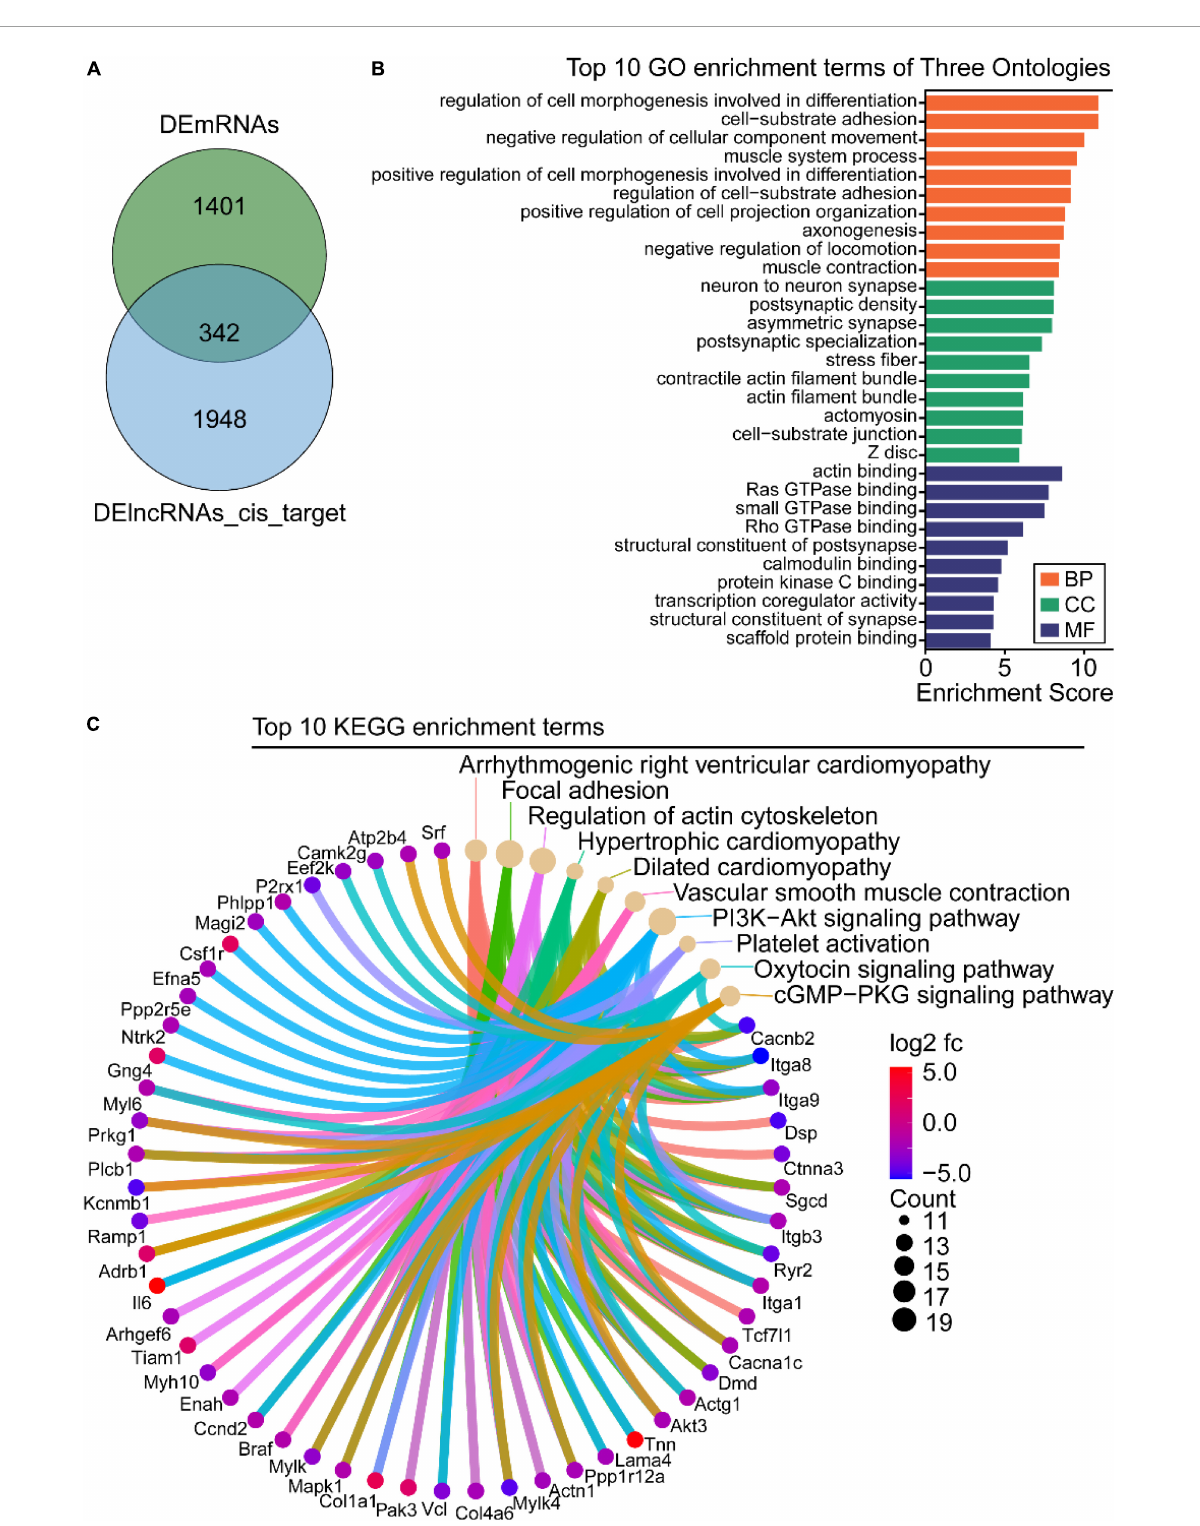
FIGURE7 Gene ontology (GO) and Kyoto Encyclopedia of Genes and Genome (KEGG) enrichment analysis of the intersection between differentially expressed long-non-coding RNAs (DElncRNAs) cis -regulated target genes and differentially expressed mRNAs (DEmRNAs). (A) Venn diagram of DEmRNAs and DElncRNAs target genes. (B) GO analysis of the intersectional genes, the three ontologies mainly include CC, BP, and MF. (C) KEGG pathway analysis of the intersectional genes between DElncRNAs target genes and